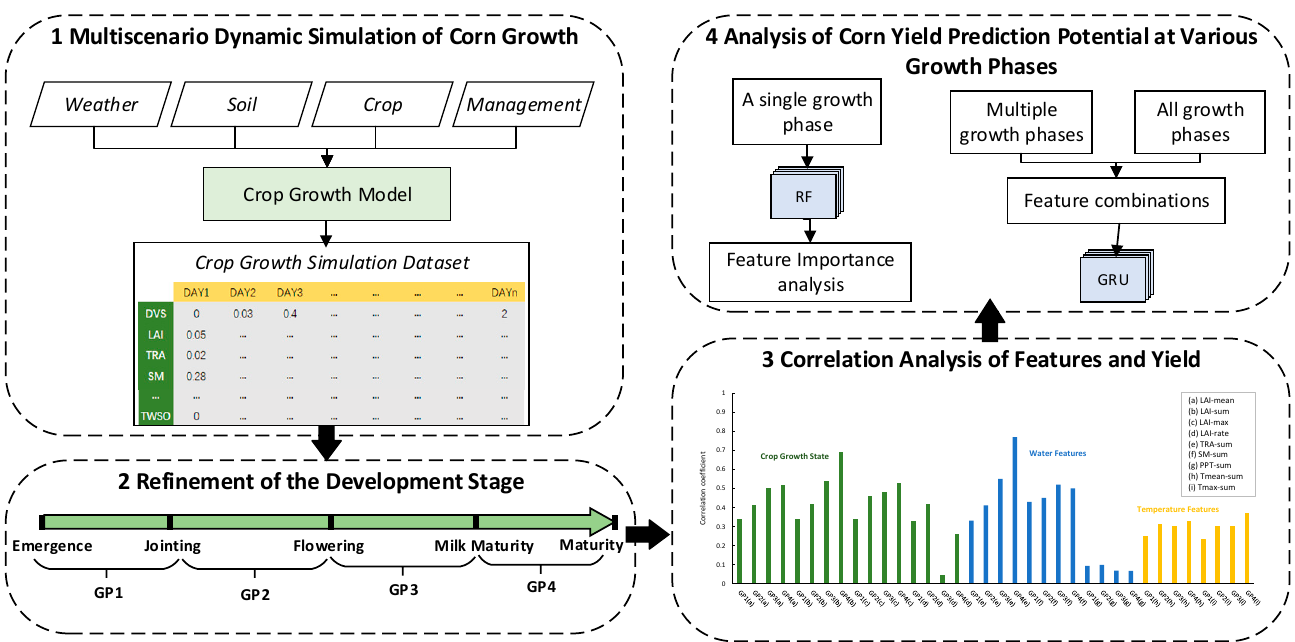
Figure 2. Research route of technology. RF represents Random Forest model. GRU represents the Gated Recurrent Unit model. GP represents growth phase. GP1 is from emergence to jointing, GP2 is from jointing to flowering, GP3 is from flowering to milk maturity, GP4 is from milk maturity to maturity.